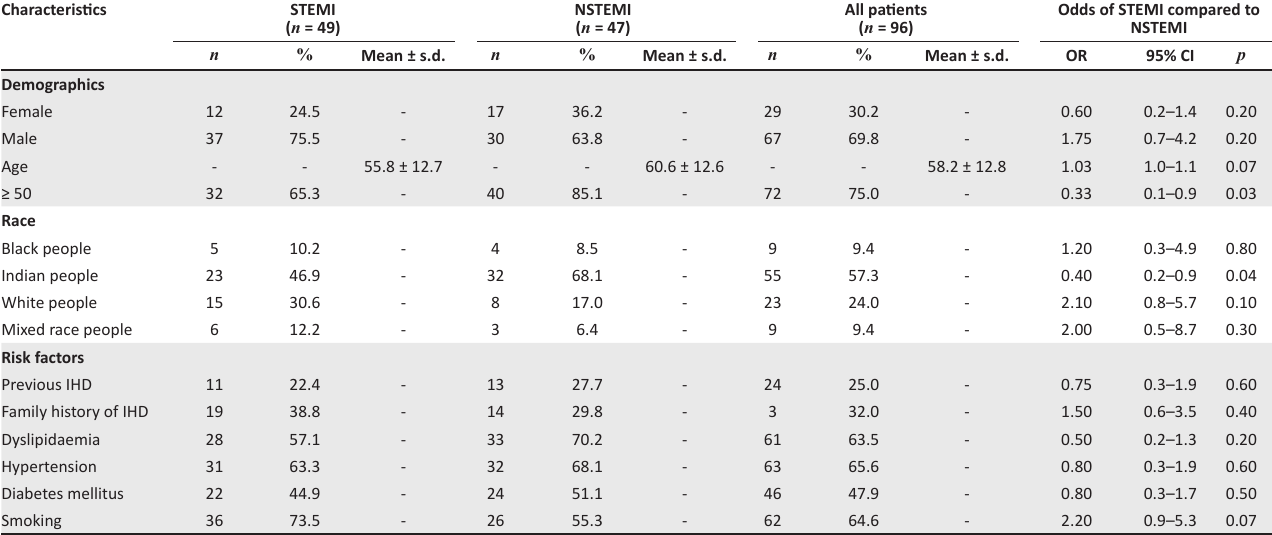
TABLE 1: Demographics and risk factor profile of patients with acute myocardial infarction.